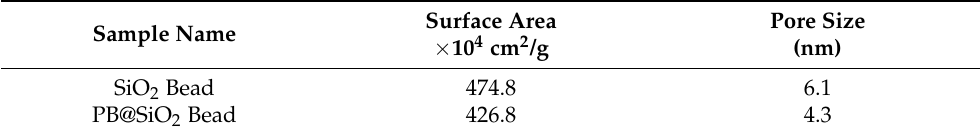
Figure 1. TEM images of PBN at different magnifications ( A , B ). Bar histogram displaying the particle size distribution curve of the nanoparticles (inset of Figure 1A). SAED pattern of as-synthesized particles ( C ), EDX profile with all the anticipated elements ( D ), XRD of EETMSi-functionalized PBN ( E ). Table 1. Parameters calculated from BET nitrogen gas adsorption